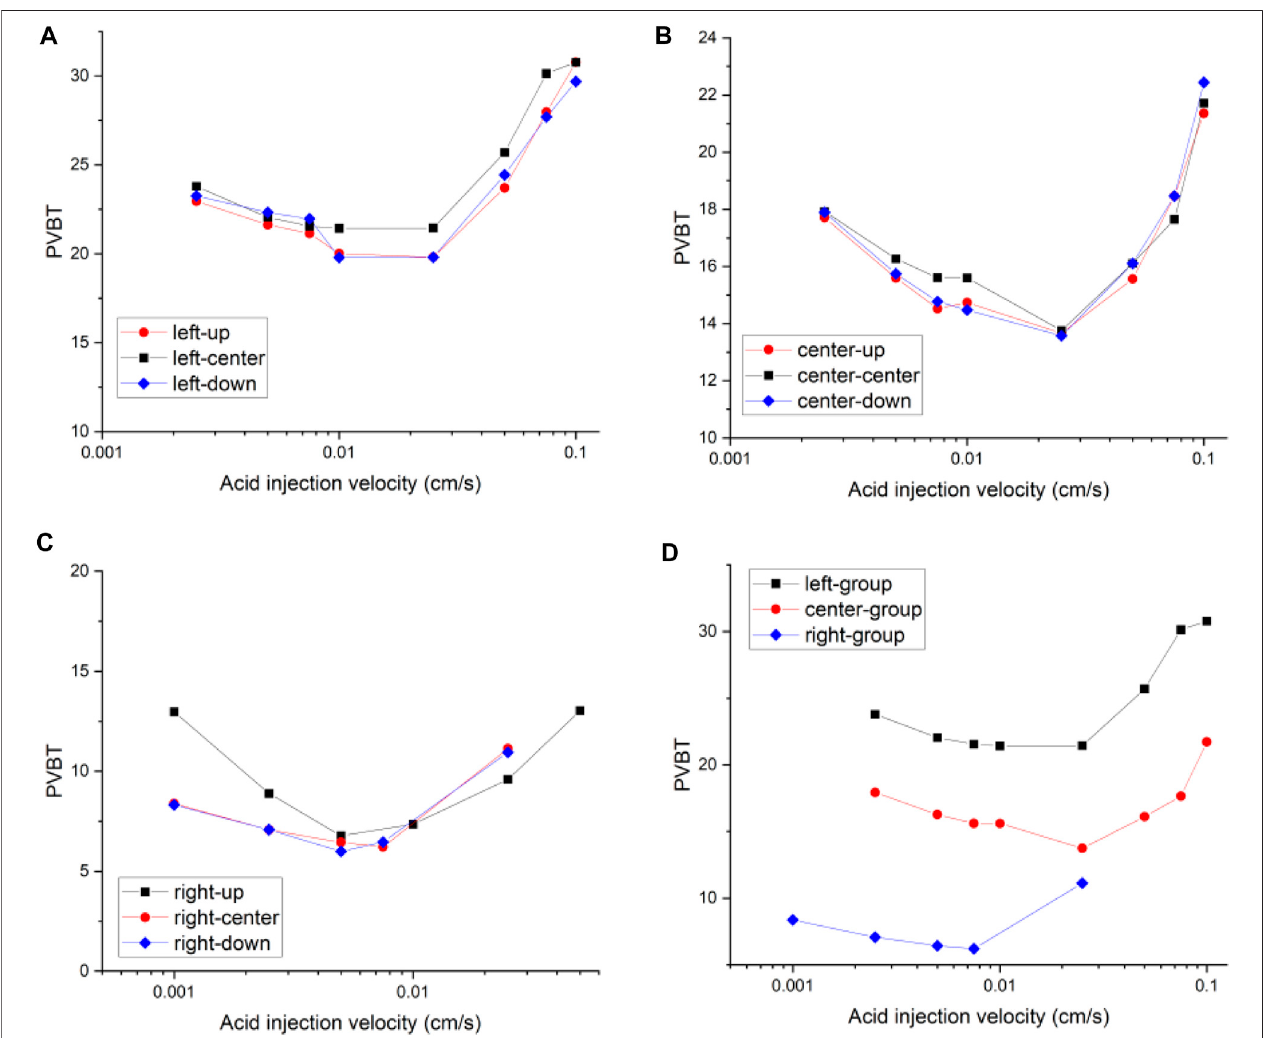
FIGURE 9 | Isolated fracture acidizing curves of pore volume to breakthrough with different locations: (A) left group; (B) center group; (C) right group; (D) group comparison.